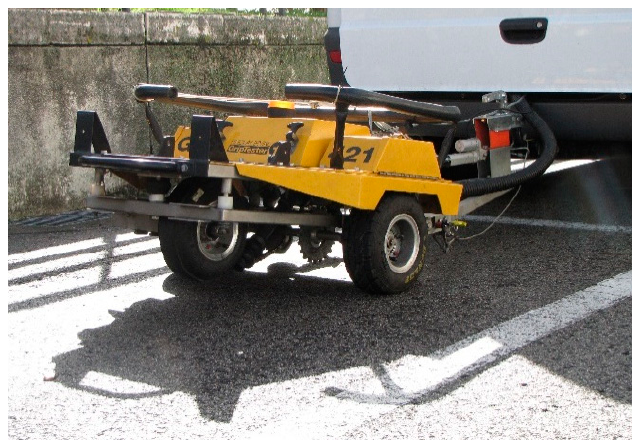
Figure 1. Grip Tester during a test.